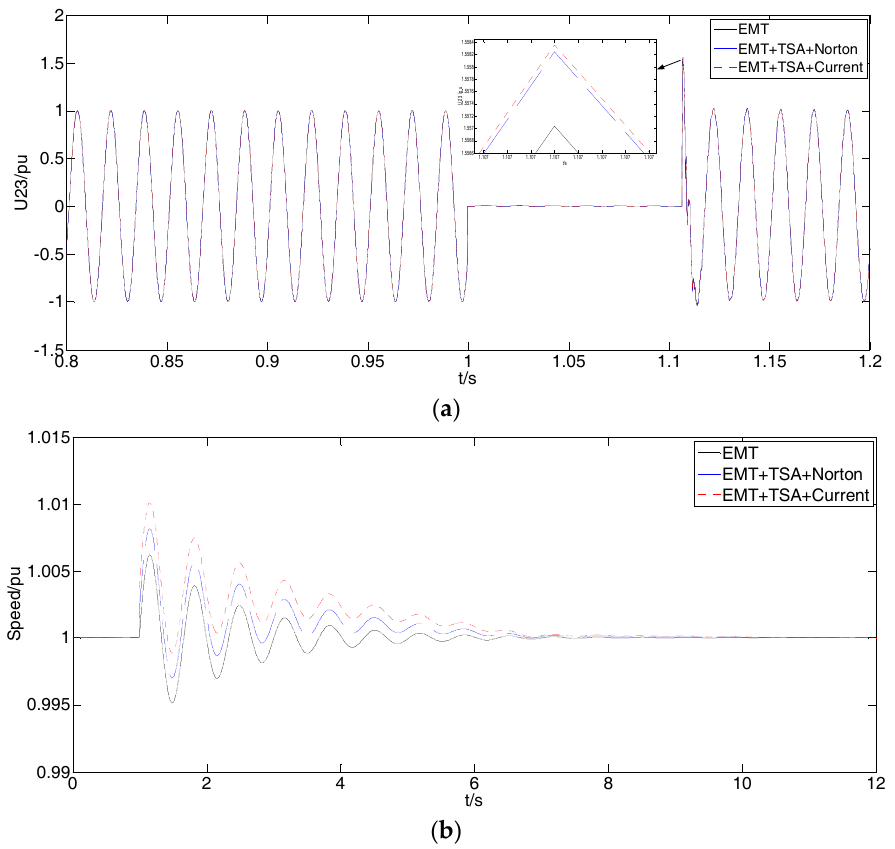
Figure 5. Verification of Norton equivalent accuracy. ( a ) Phase A voltage at bus 23; and, ( b ) Rotor speed of generator at bus 25.